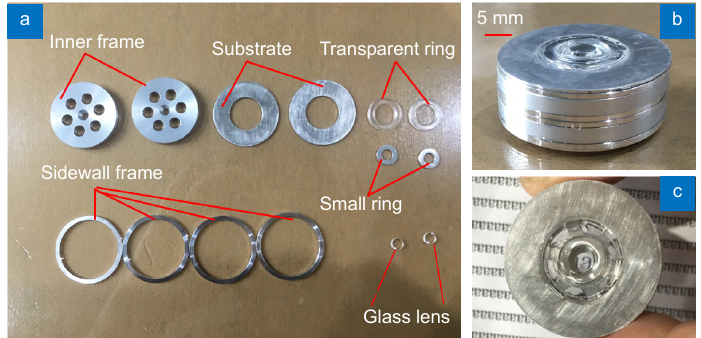
Fig. 3 | Fabricated prototype of the movable electrowetting optofluidic lens. ( a ) All the elements of the device. ( b ) Assembled prototype (Side view). ( c ) Assembled prototype (Top